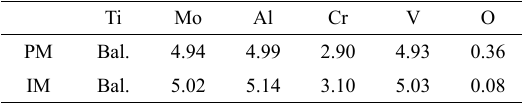
Table 1. Chemical compositions of as-consolidated PM and as- cast IM Ti-5553 (wt%). Ti